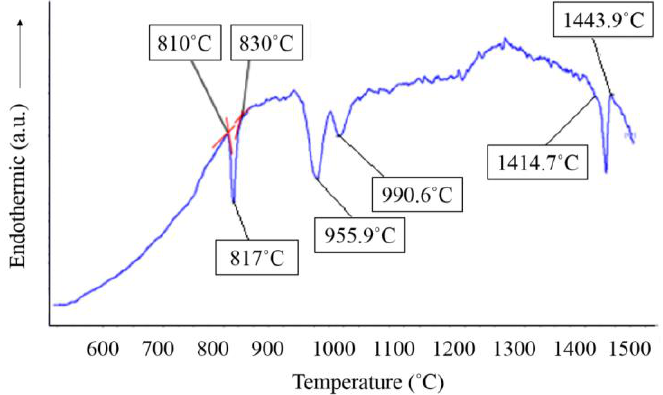
Figure 2. DSC traces measured from the as-received modified Grade 440 MSS at a heating rate of 5 K/min.